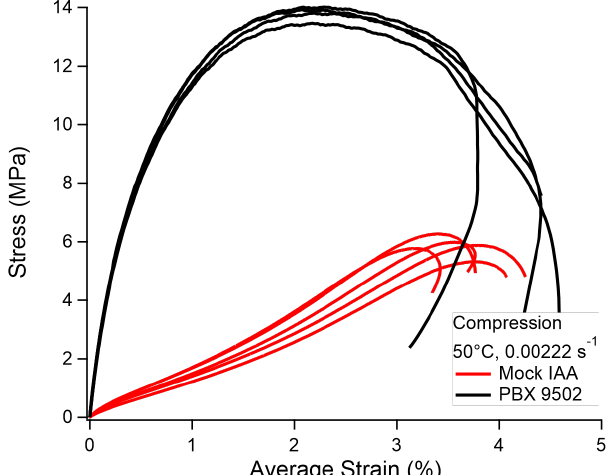
Figure 8. Stress–strain data for quasi-static compression of Mock IAA and PBX